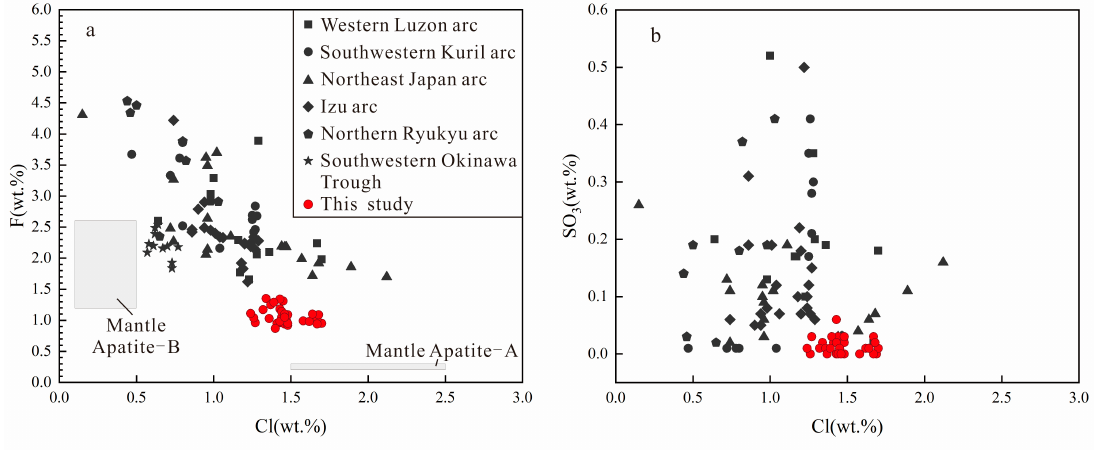
Figure 6. Plots of ( a ) F versus Cl in apatites of dacite; ( b ) SO 3 versus Cl in apatites of dacite (data from [42,45] and this